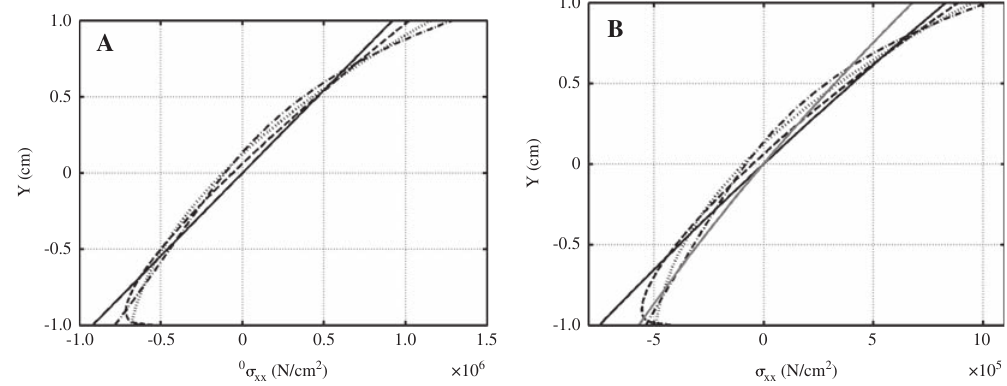
Figure 10 (A) Normal stress distributions in the geometrically linear case. (B) Cauchy normal stress distributions for various values of the power-law exponent at fi xed end for q = 500 N/cm 2 . ( – – – – ) Full ceramic, ( – – – ) k = 0.3, (------) k = 1, ( – – – ) k = 3, ( – – – – ) full metal.